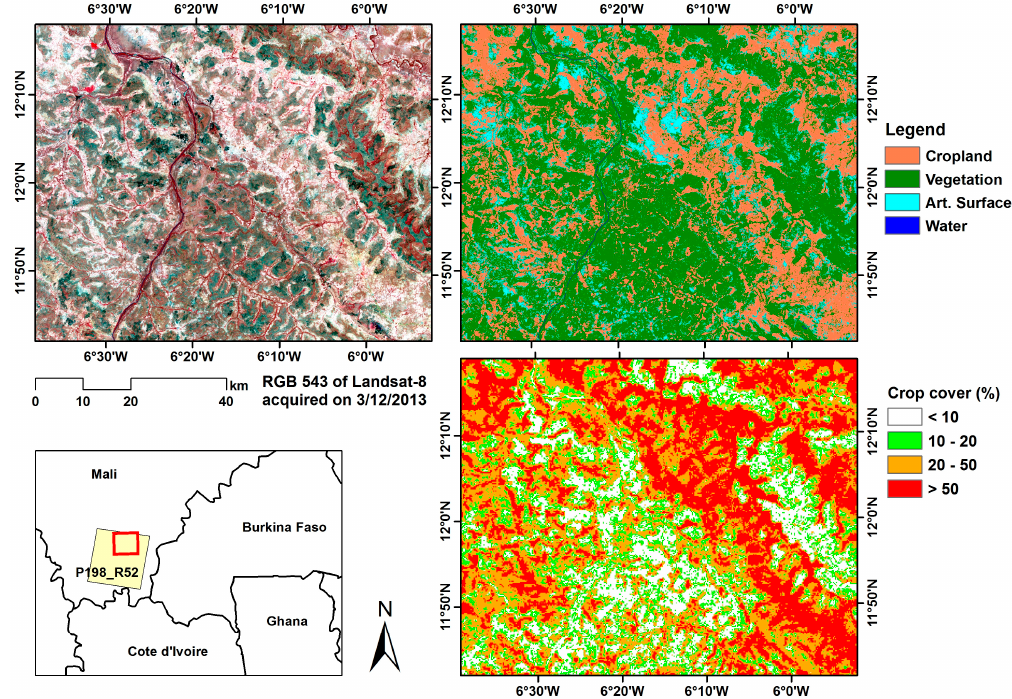
Figure 8. Comparison of: Landsat false color composite ( top left ); Landsat classification results ( top right ); and the modeled fractional cropland cover ( bottom right ).